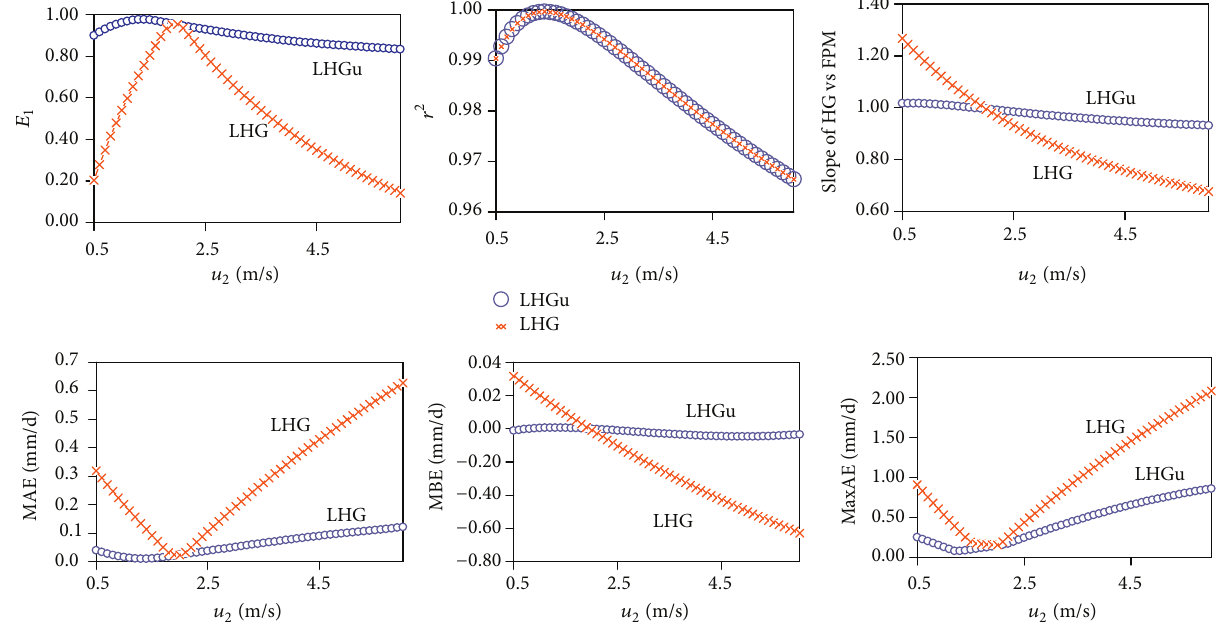
Figure 3: Performance statistics ( 𝐸 1 , slope, MxAE, MBE, MAE, and 𝑟 2 ) of LGHu and LHG when applied to various constant daily 𝑢 2 data and 2007 Accra temperature data to estimate FPM ET 𝑜